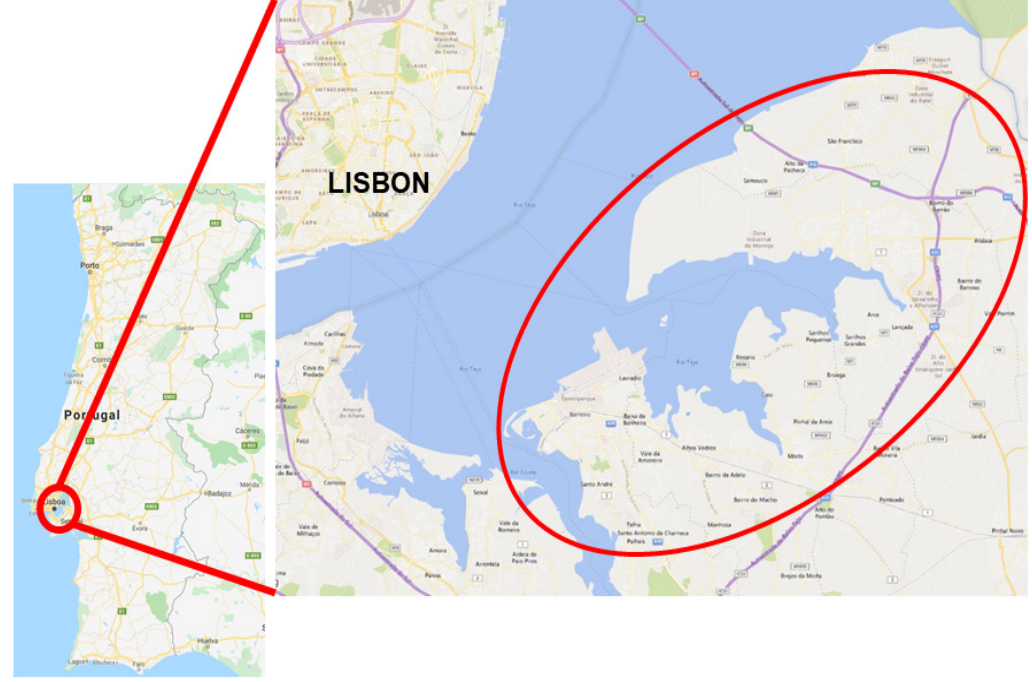
Figure 1. Map of the region where the study took place.